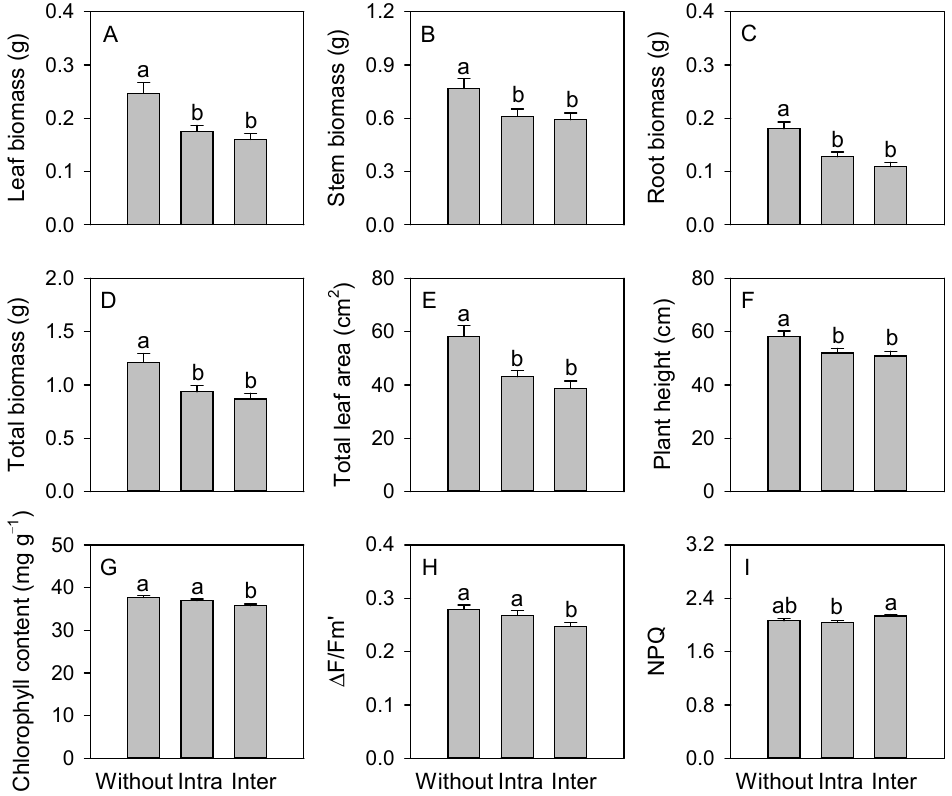
Figure 3. Leaf biomass ( A ), stem biomass ( B ), root biomass ( C ), total biomass ( D ), total leaf area ( E ), plant height ( F ), total chlorophyll content ( G ), Δ F/Fm’ ( H ), and NPQ ( I ) of P. hydropiper under treat- ments with intraspecific competition (i.e., Intra), with interspecific competition (i.e., Inter), or with- out competition (i.e., Without). Data are mean values (+s.e., n = 6). Different letters indicate signifi- cant differences ( p < 0.05).